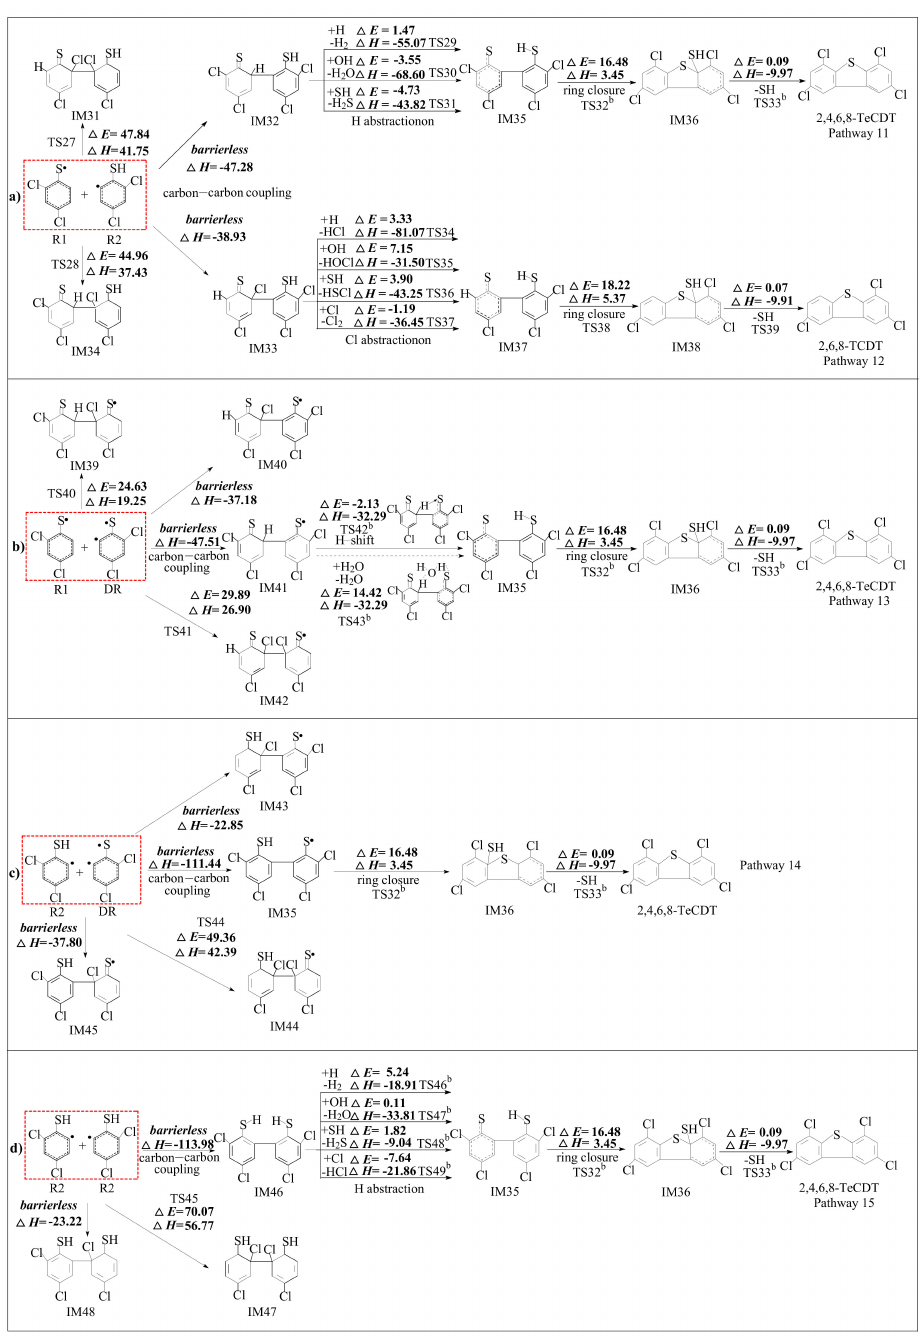
Figure 4. Polychlorinated dibenzothiophene (PCDT) formation routes embedded with the potential barriers ∆ E (in kcal / mol) and reaction heats ∆ H (in kcal / mol) from self- and cross-couplings of R1 + R2 ( a ), R1 + DR ( b ), R2 + DR ( c ), and R2 + R2 ( d ). ∆ H is calculated at 0 K. ( b Reproduced with permission from Xu et al.